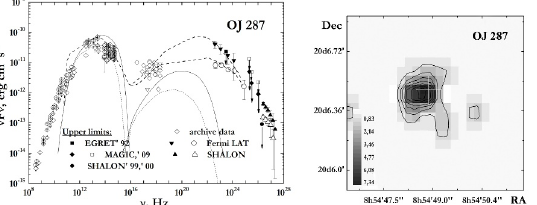
Figure 1. Spectral energy distribution of OJ 287. △ show the average spectrum; ▲ show the flaring spectra from the SHALON data. Emission map of OJ 287 by SHALON (grey